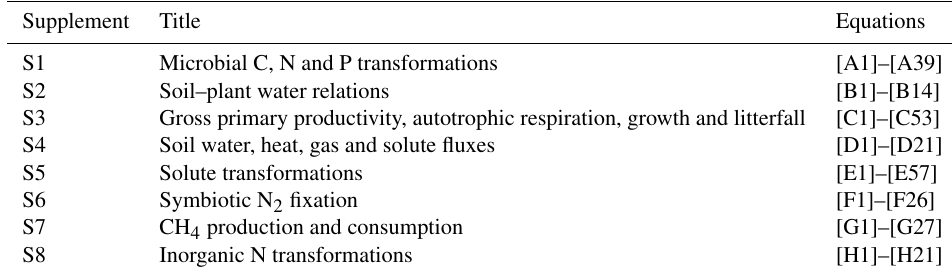
Table 1. List of sections in the Supplement.